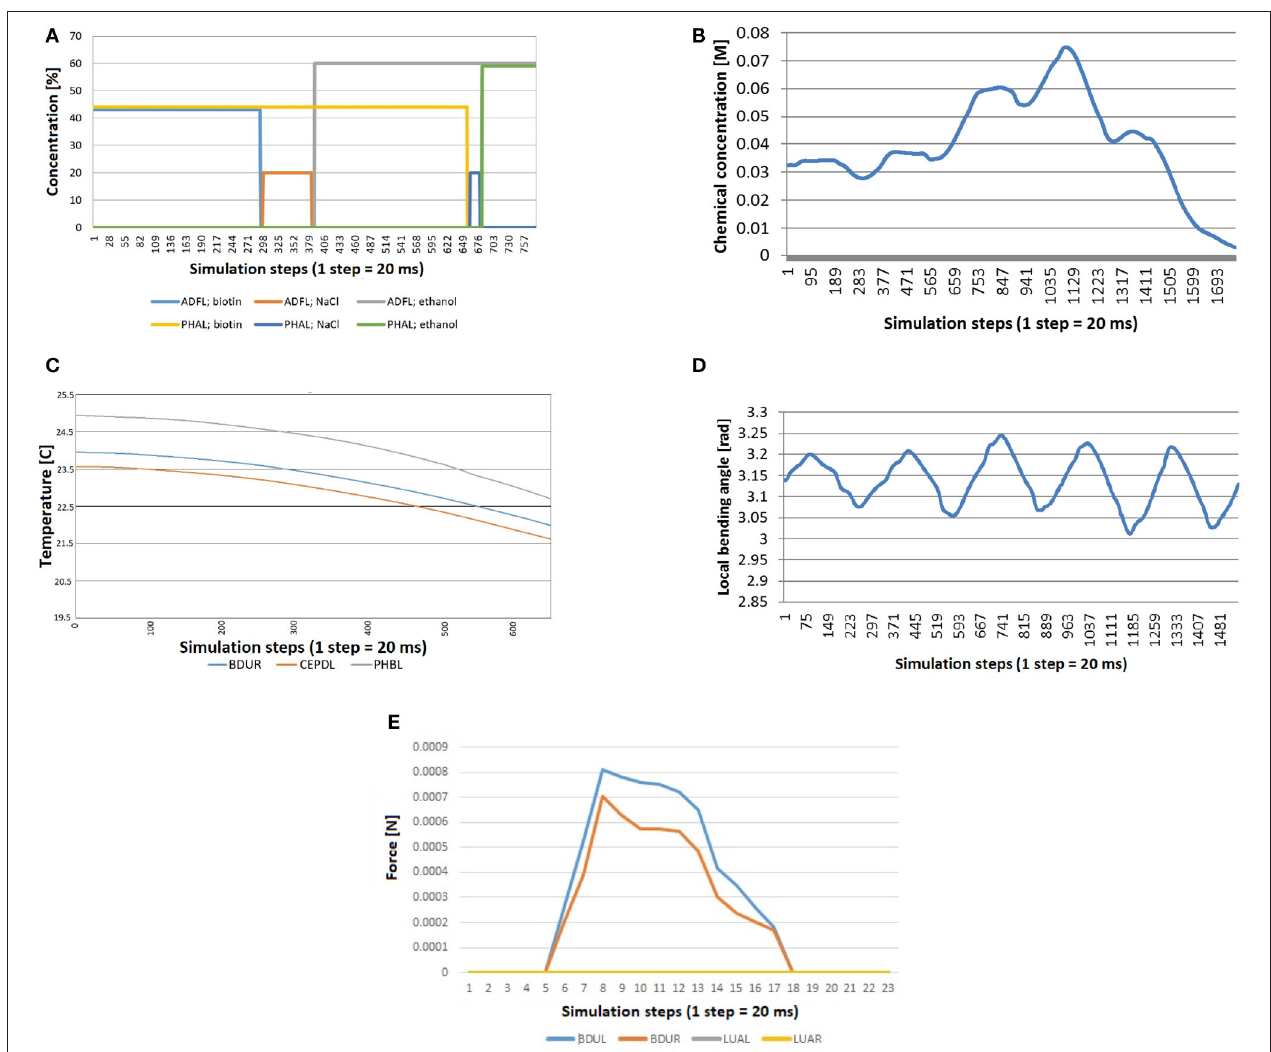
FIGURE 10 | Stimuli computed during simulation, because they depend on the position and the shape of the worm at each moment. (A) Quadrants assay: the worm crosses quadrants and barriers and consequently neurons receive concentration of different chemicals. (B) Chemosensation received by the neuron IL1R when the worm crawls across a gradient generated with a chemical drop. (C) Thermosensation stimulus in BDUR, CEPDL, and PHBL when the C. elegans crosses a lineal thermal gradient. (D) Proprioception stimulus in AS3 when the locomotion of the nematode is activated with a CPG. (E) Mechanosensation induced by collision between an obstacle and the head of the worm. Neurons in the head (BDUL and BDUR) are activated and the stimulus was not received by the neurons that are not located in the head (LUAL and